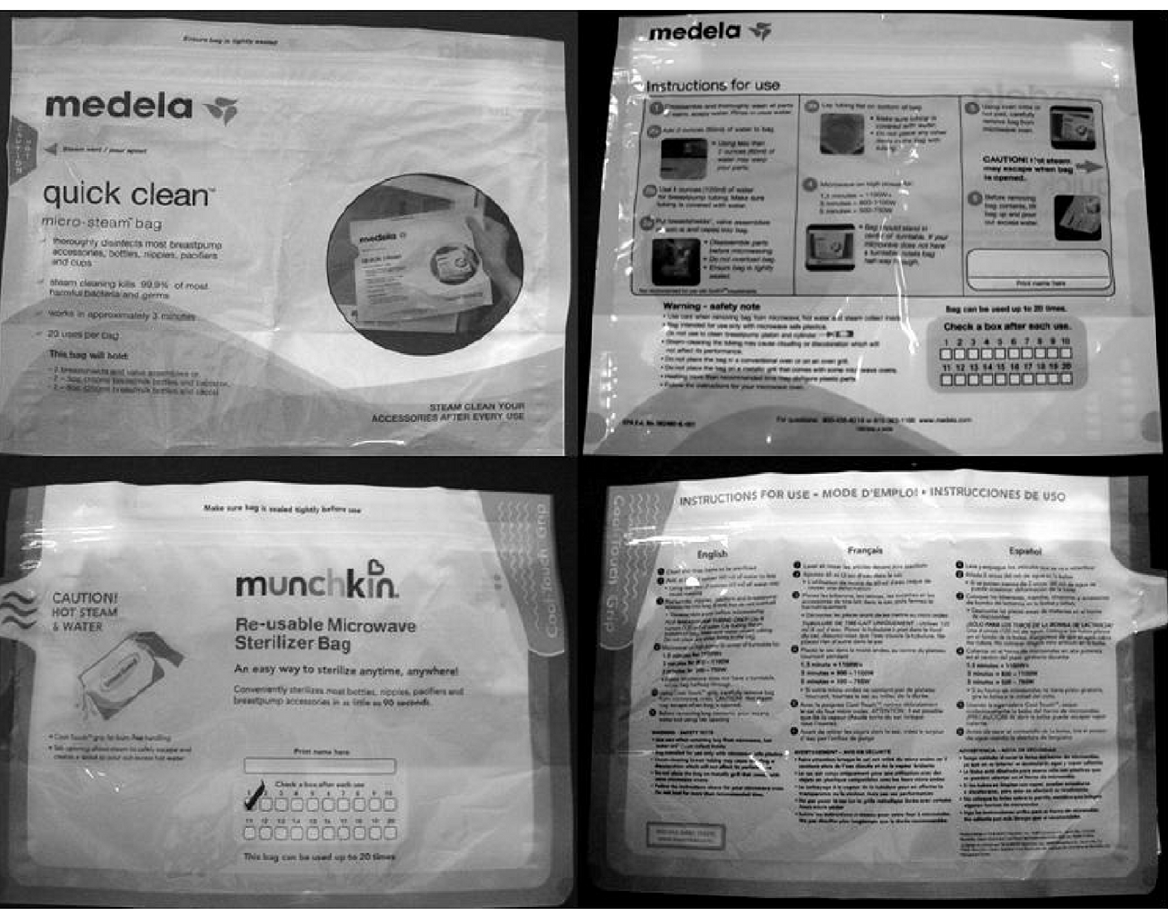
Figure 1. Photographs of the front (left) and back (right) panels of the microwave steam bags. Top: MSB X bags. Bottom: MSB Y bags.